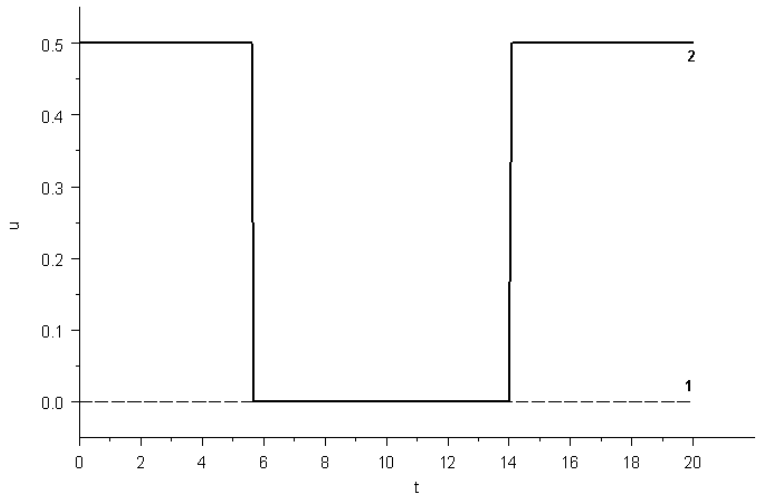
Figure 1. 1—control u = 0; 2—computational control u .